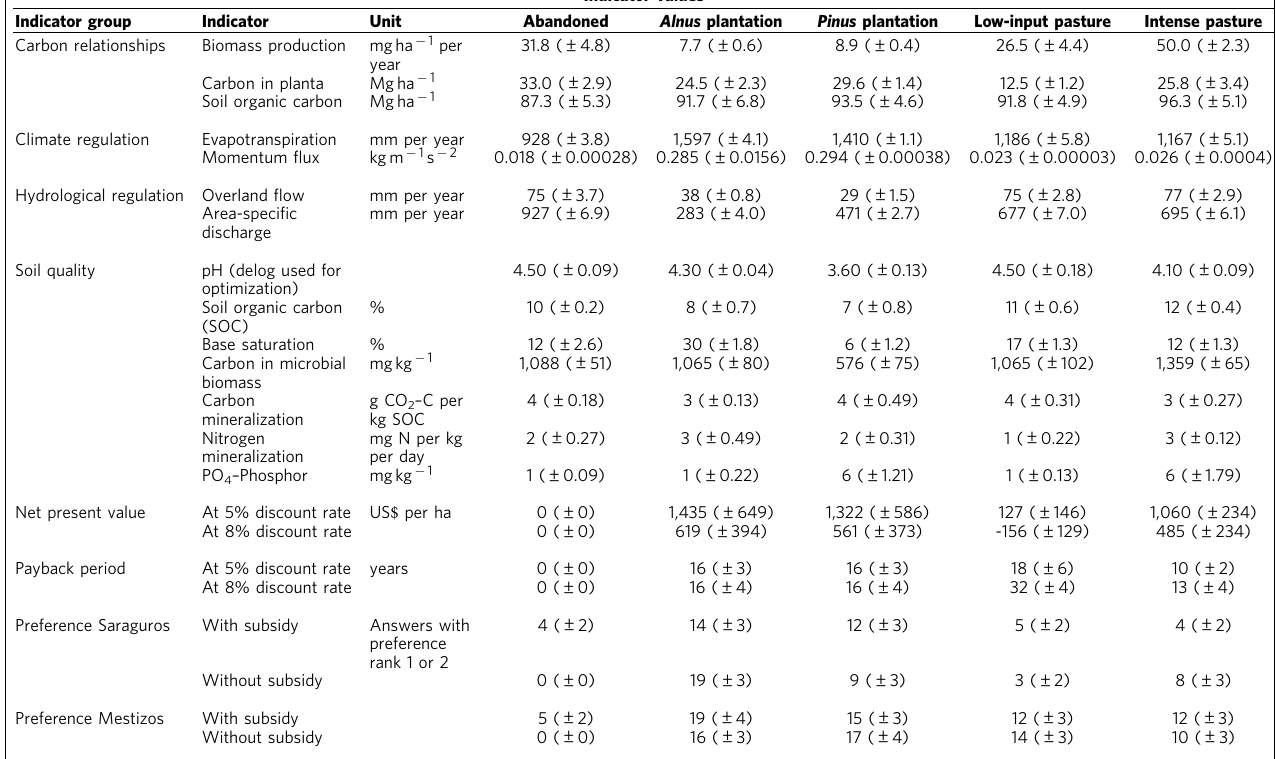
Table 1 | Considered indicators and their uncertainties, adopted from Knoke et al. 14 (to quantify possible deviations from recorded indicator levels we use the s.e.m. li , for each land-cover type, l , and indicator, i , given in